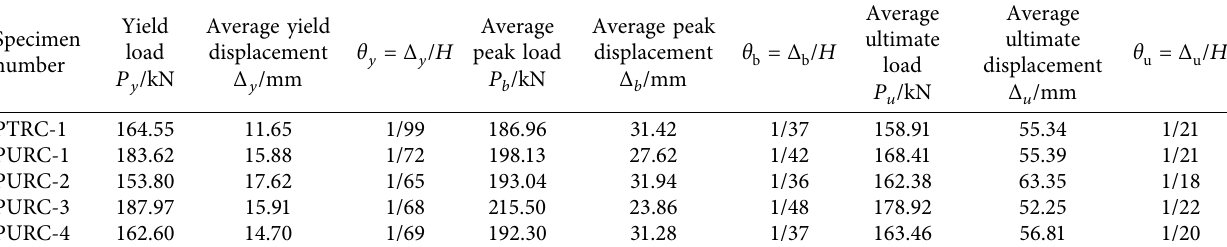
Table 5: Average value of load and displacement angle of specimens.